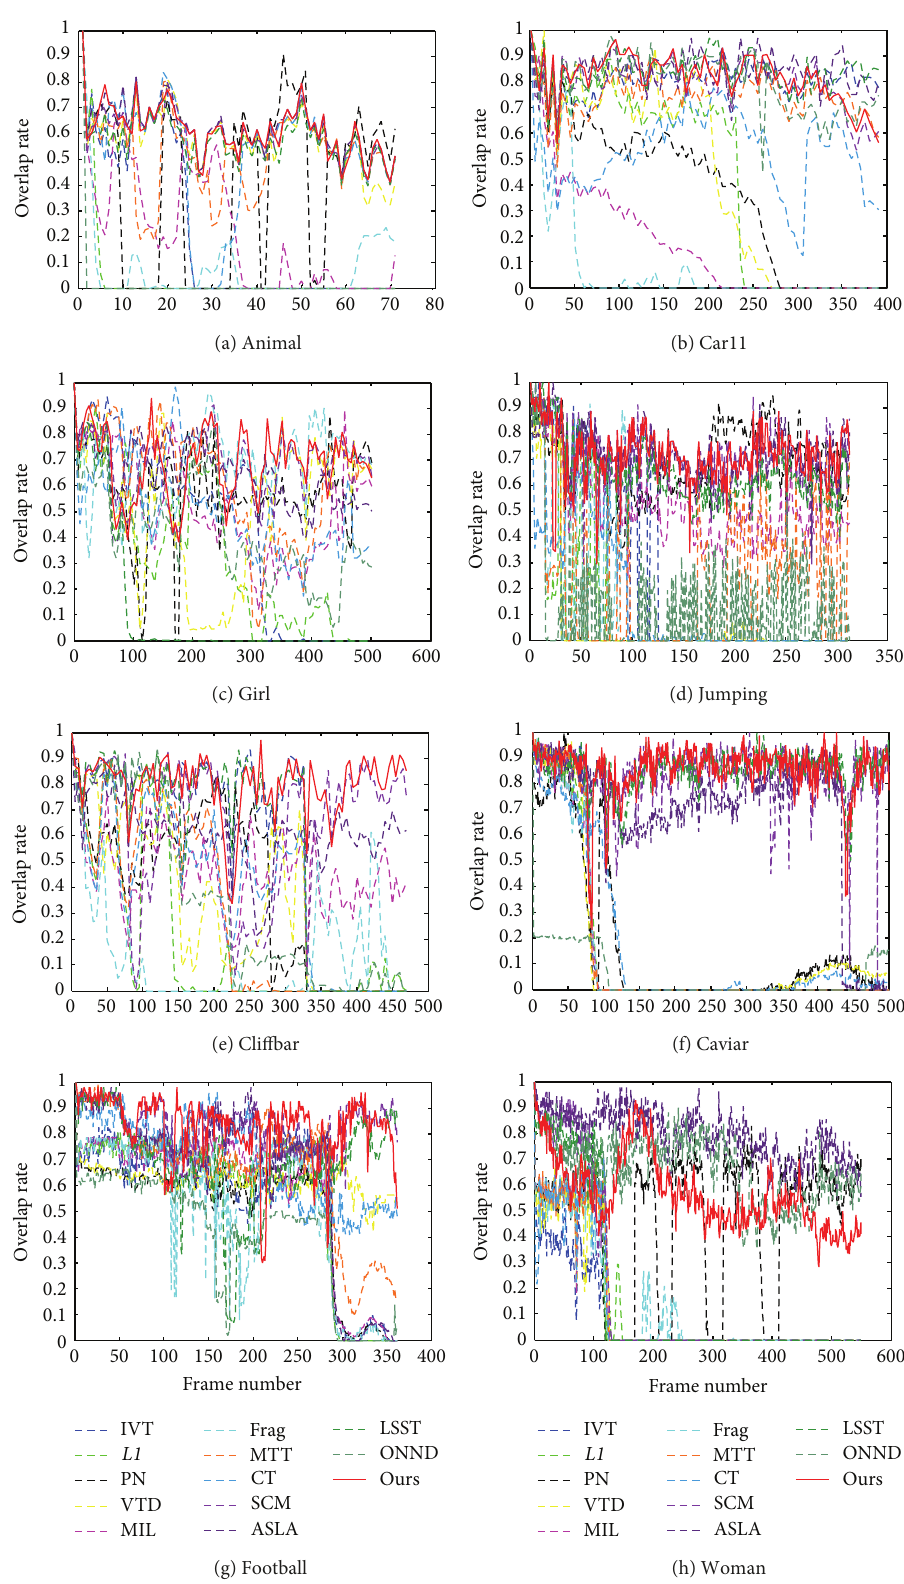
Figure 2: Overlap rate evaluation. This figure shows overlap rates for ten tested video clips. Our algorithm is compared with ten state-of-the- art